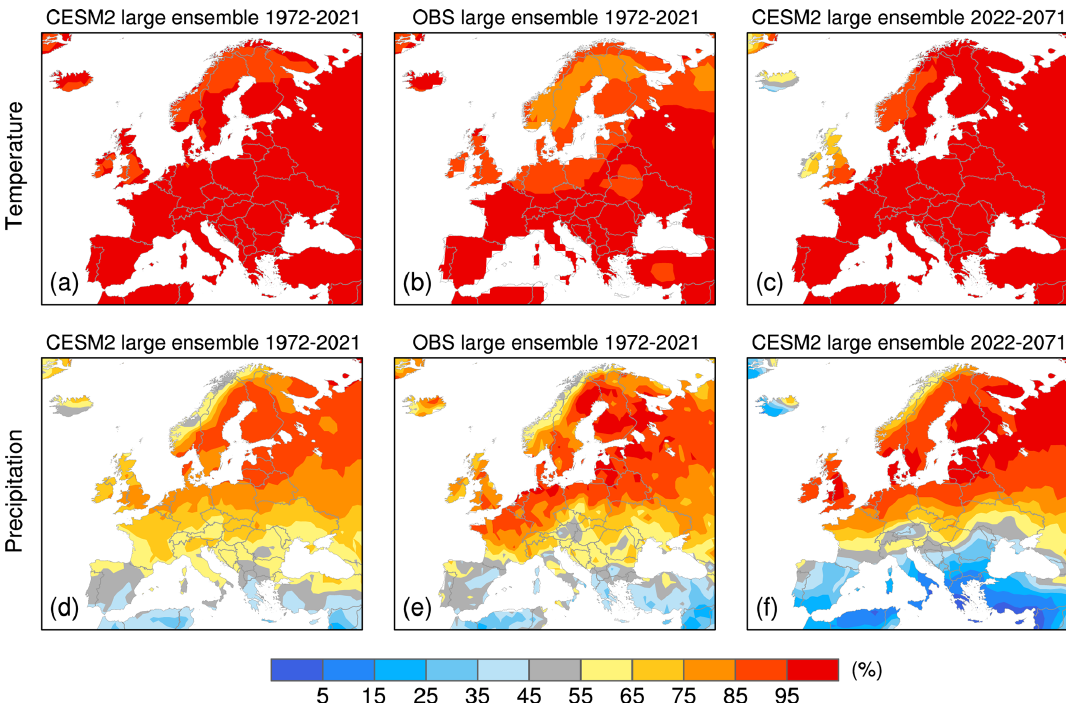
Figure 9. The percentage of ensemble members with a positive trend in winter (a–c) air temperature and (d–f) precipitation trends based on (a, d) the 100-member CESM2 large ensemble during 1972–2021, (b, e) the 100-member observational large ensemble during 1972–2021, and (c, f) the 100-member CESM2 large ensemble during